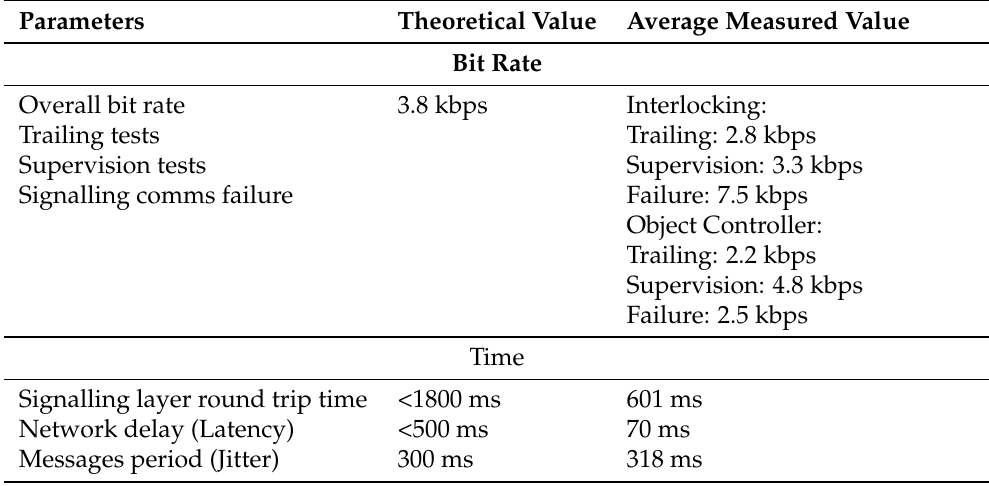
Table 2. Network KPIs. Average values measured in the application layer: signalling critical services.